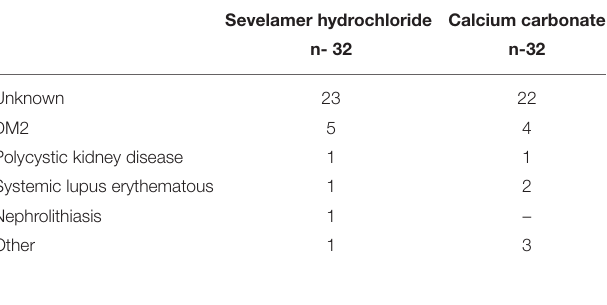
TABLE 2 | ESRD causes.